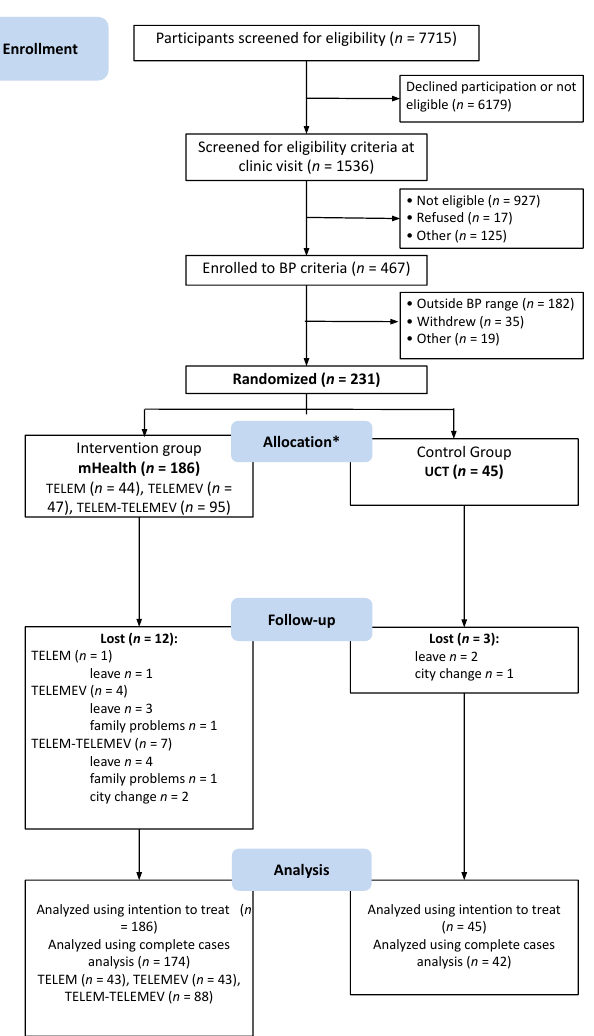
Figure 1. Study flowchart describing selection, randomization, and follow-up process. BP indicates blood pressure. * All participants received the allocated